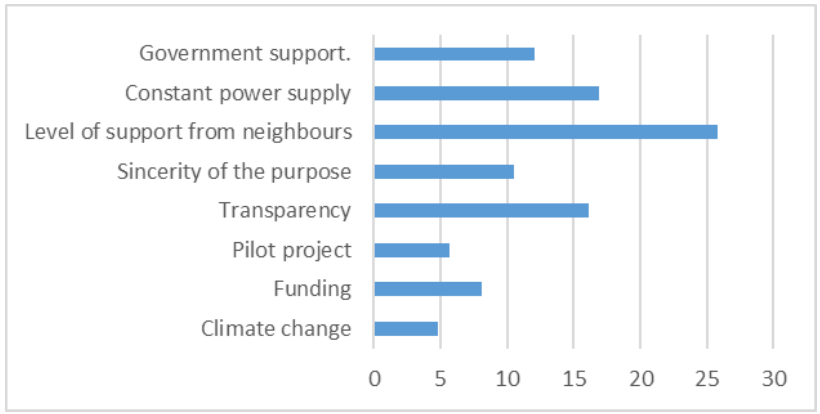
Figure 2. Residents’ motivation to cooperate with neighbors in a CREI (in